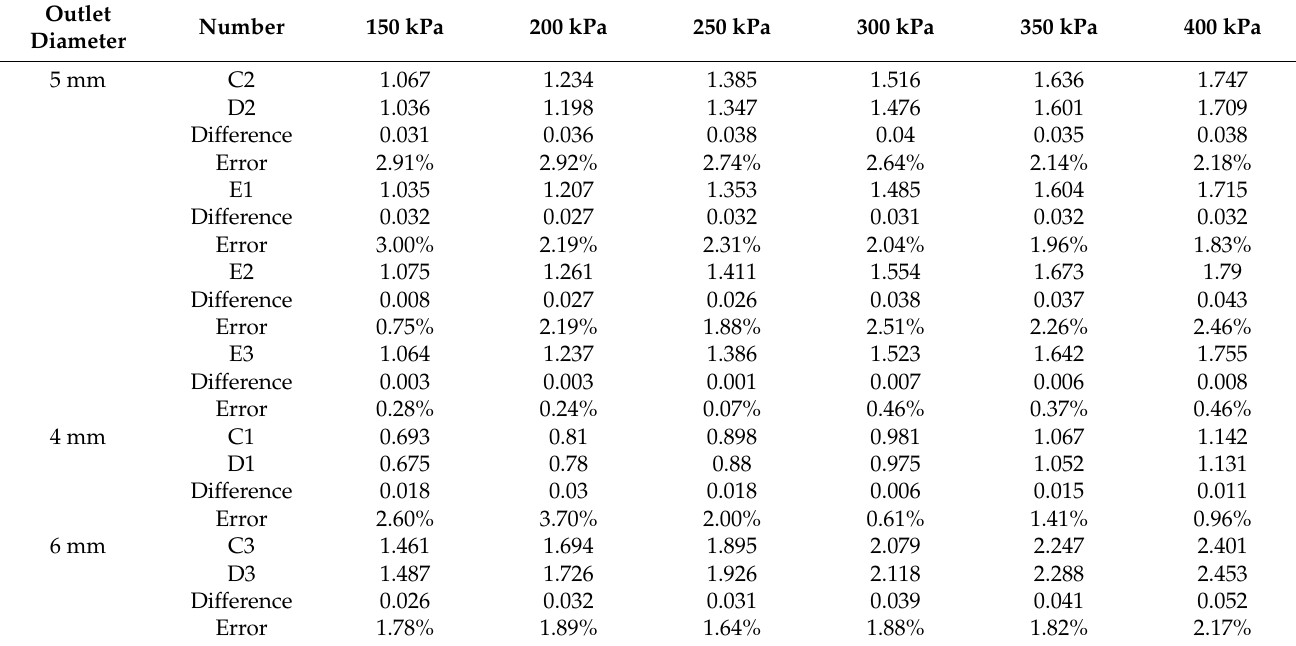
Figure 3. Photograph of the sprinkler and nozzles used in experiments. Table 2. Flow error analysis of equivalent-flow nozzles (the units of flow: m 3 /h).